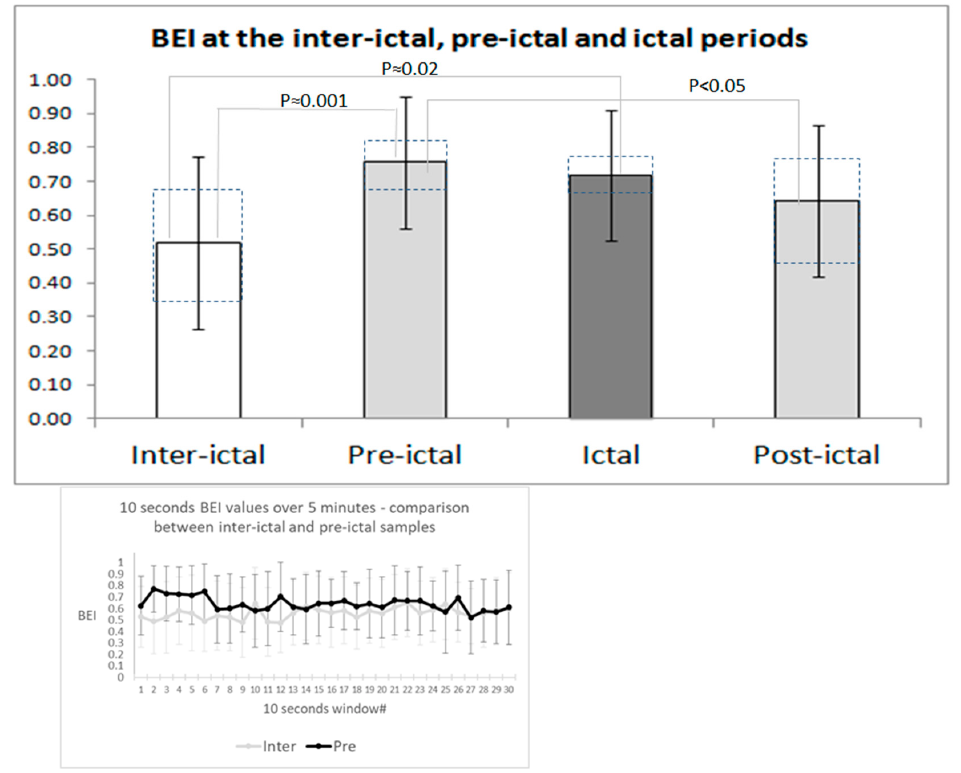
Figure 2. Brain Engagement Index (BEI) dynamics between migraine periods.